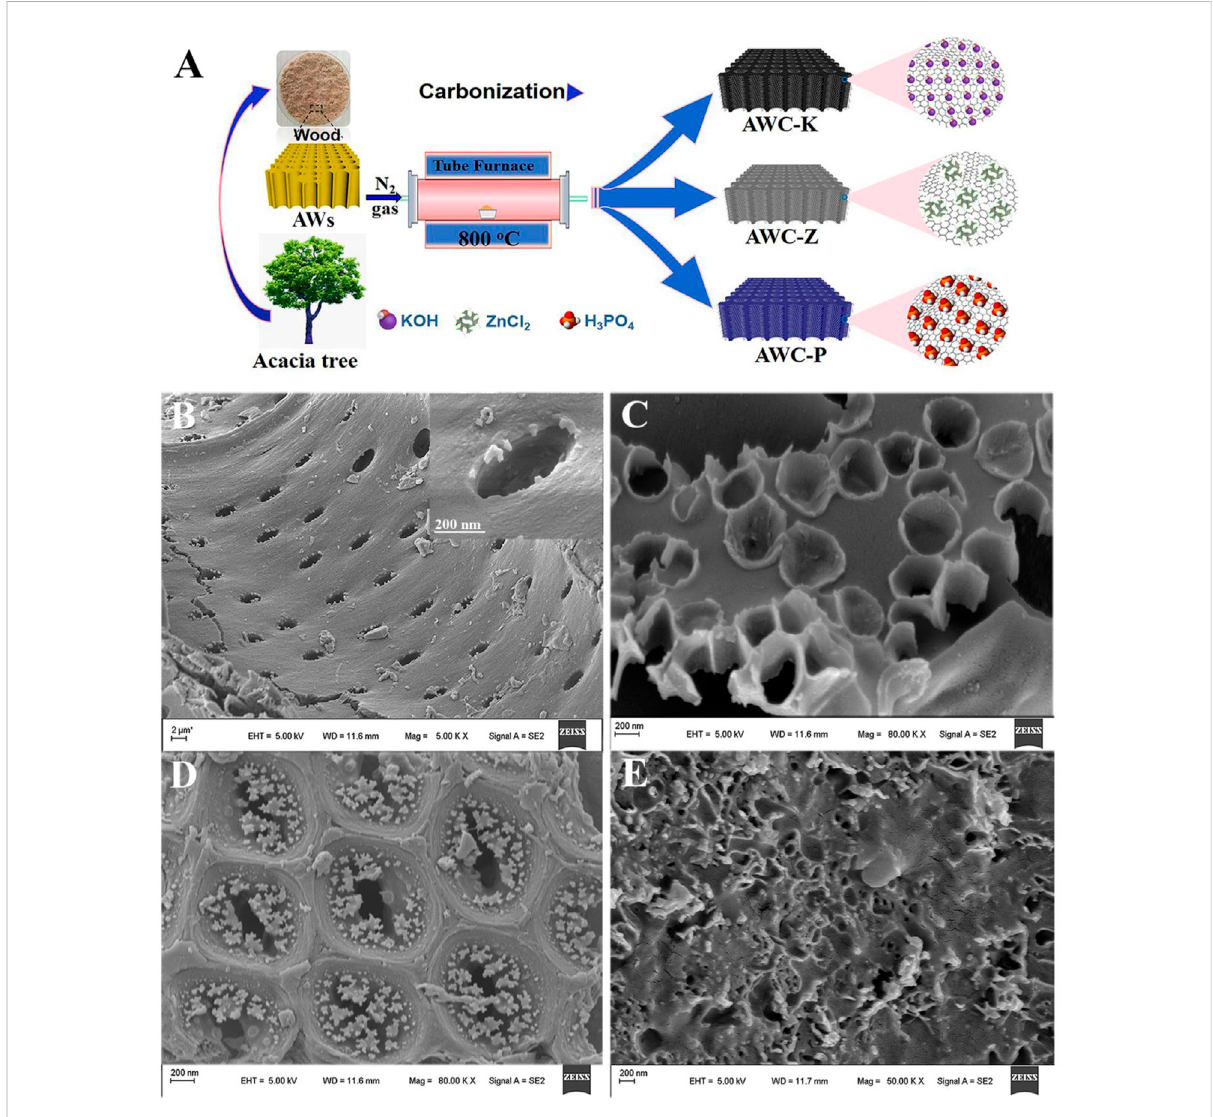
FIGURE 1 (A) Thediagramdepictingthesynthesisofcarbonmaterialsfromacaciawood;FE-SEMimagesof (B) AWs; (C) AWC-K; (D) AWC-Zand (E) AWC- P